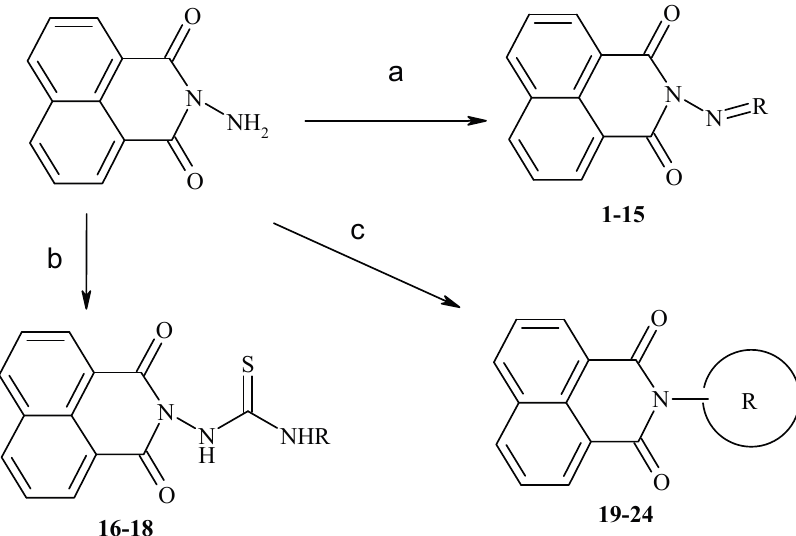
Figure 1. Main routes for synthesis of the target compounds 1 – 24